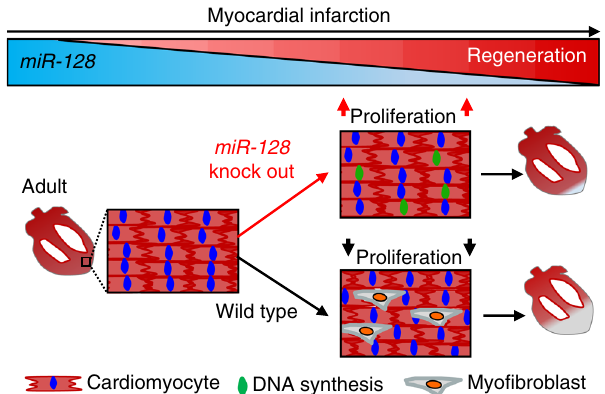
Fig. 10 Loss of miR-128 activates endogenous cardiac regeneration.